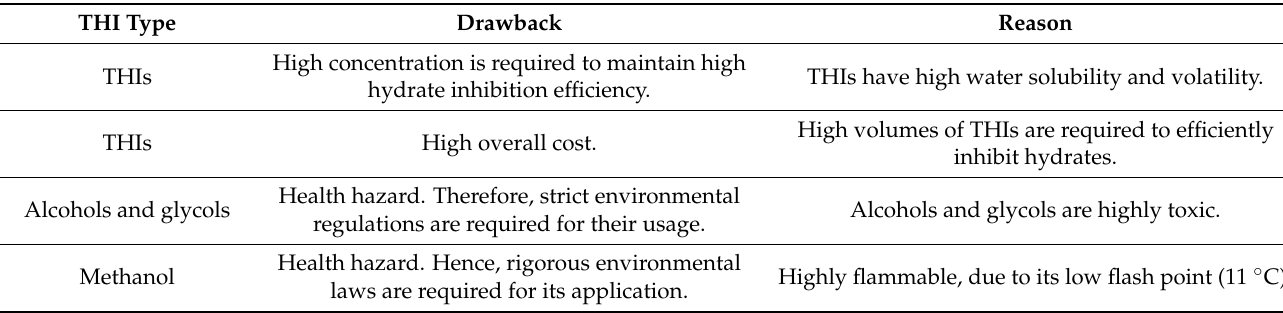
Table 14. Drawbacks of using THIs in oil/gas operations.